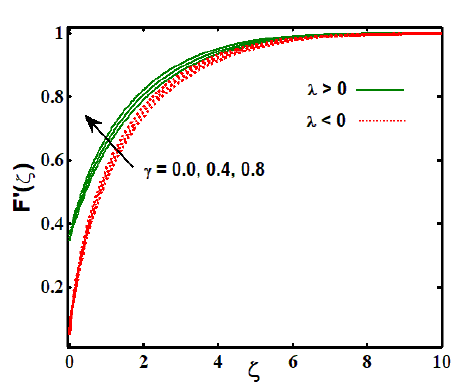
Figure 4. Effects of the 𝑆 on the 𝐹′(𝜁) .